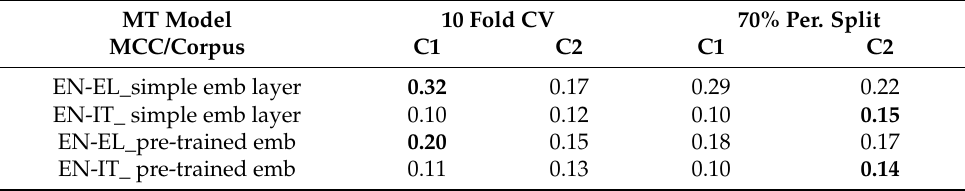
Table 3. Accuracy performance (MMC) in different cross validation